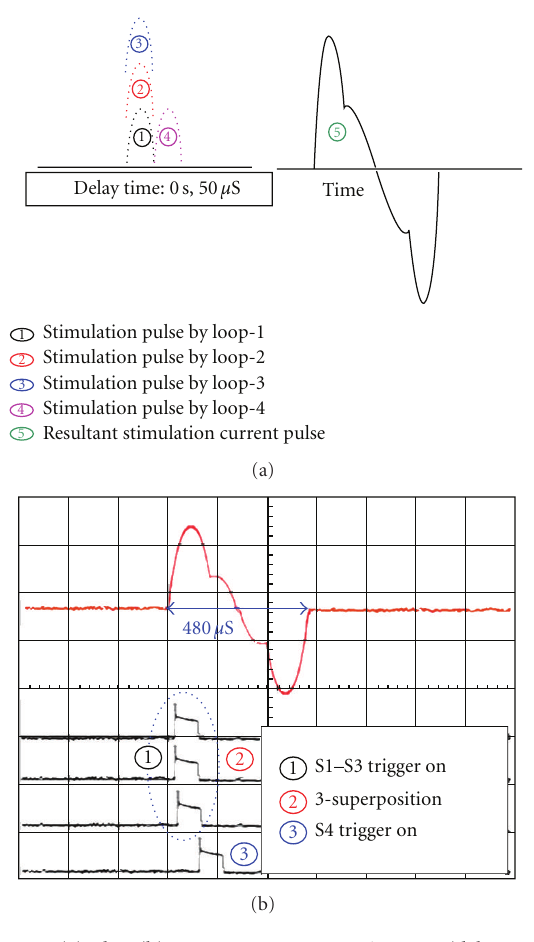
Figure 6: (a) Idea, (b) test. S1, S2, S3 → S4: trigger on (delay: 0 s, 50 μ S; pulse width: 480 μ S).